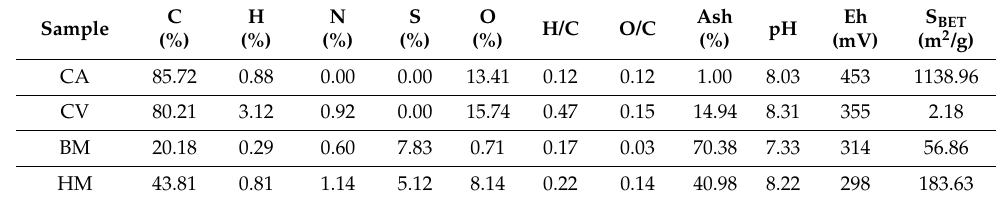
Table 1. Main characteristics of carbon-based